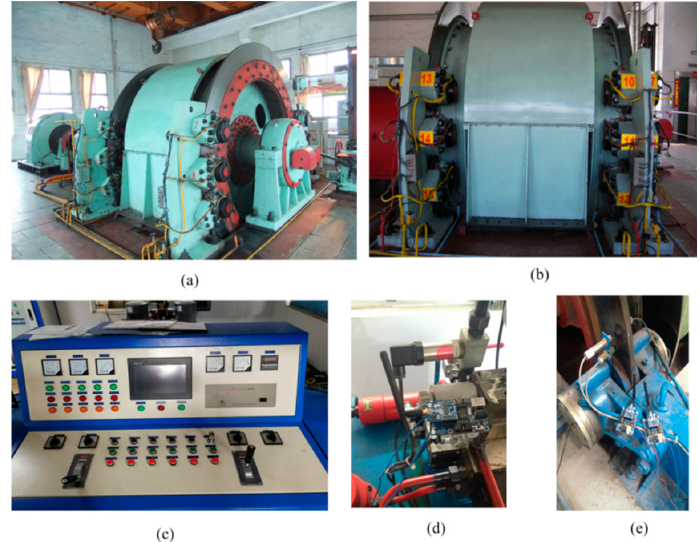
Figure 6. Field diagram of test equipment. ( a ) Main shaft device of a hoist; ( b ) brake device; ( c ) operating table; ( d ) wireless acquisition of the pressure signal in a hydraulic station; and ( e ) wireless acquisition of brake disc space.